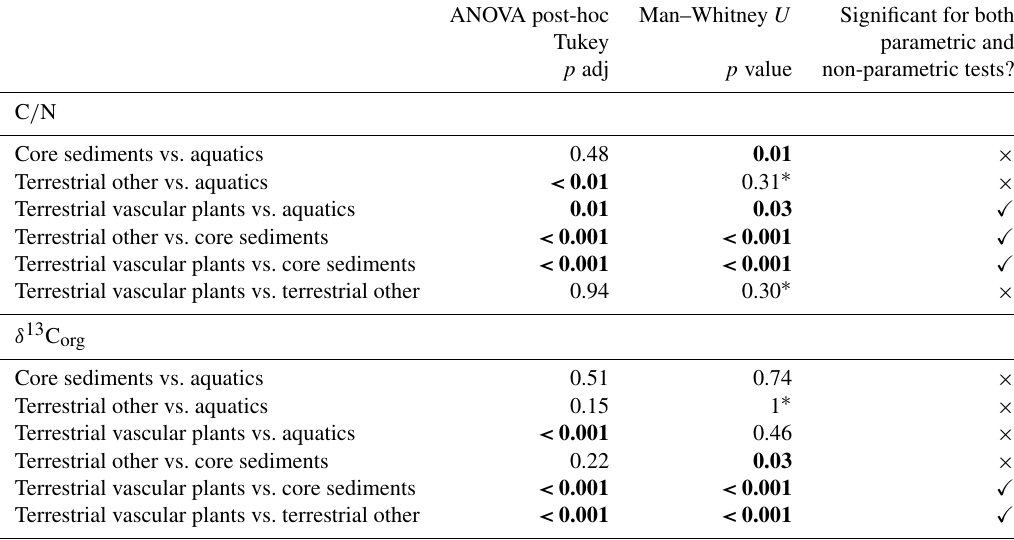
Table 3. Significant differences between pairings using parametric ANOVA post-hoc Tukey and non-parametric Mann–Whitney U . ANOVA post-hoc Man–Whitney U Significant for both Tukey parametric